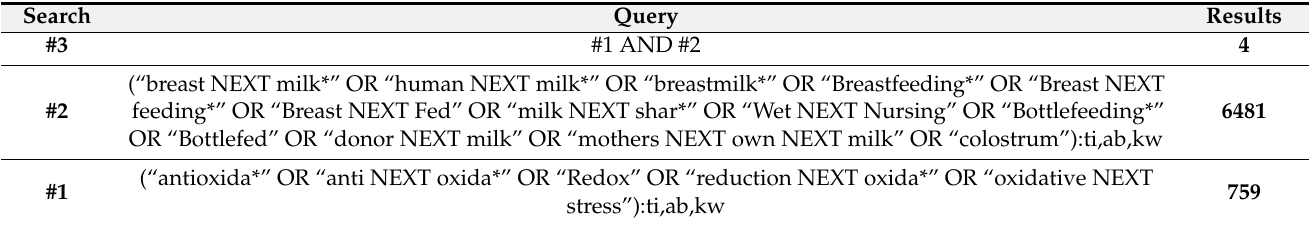
Table A5. Search strategy in Wiley/Cochrane